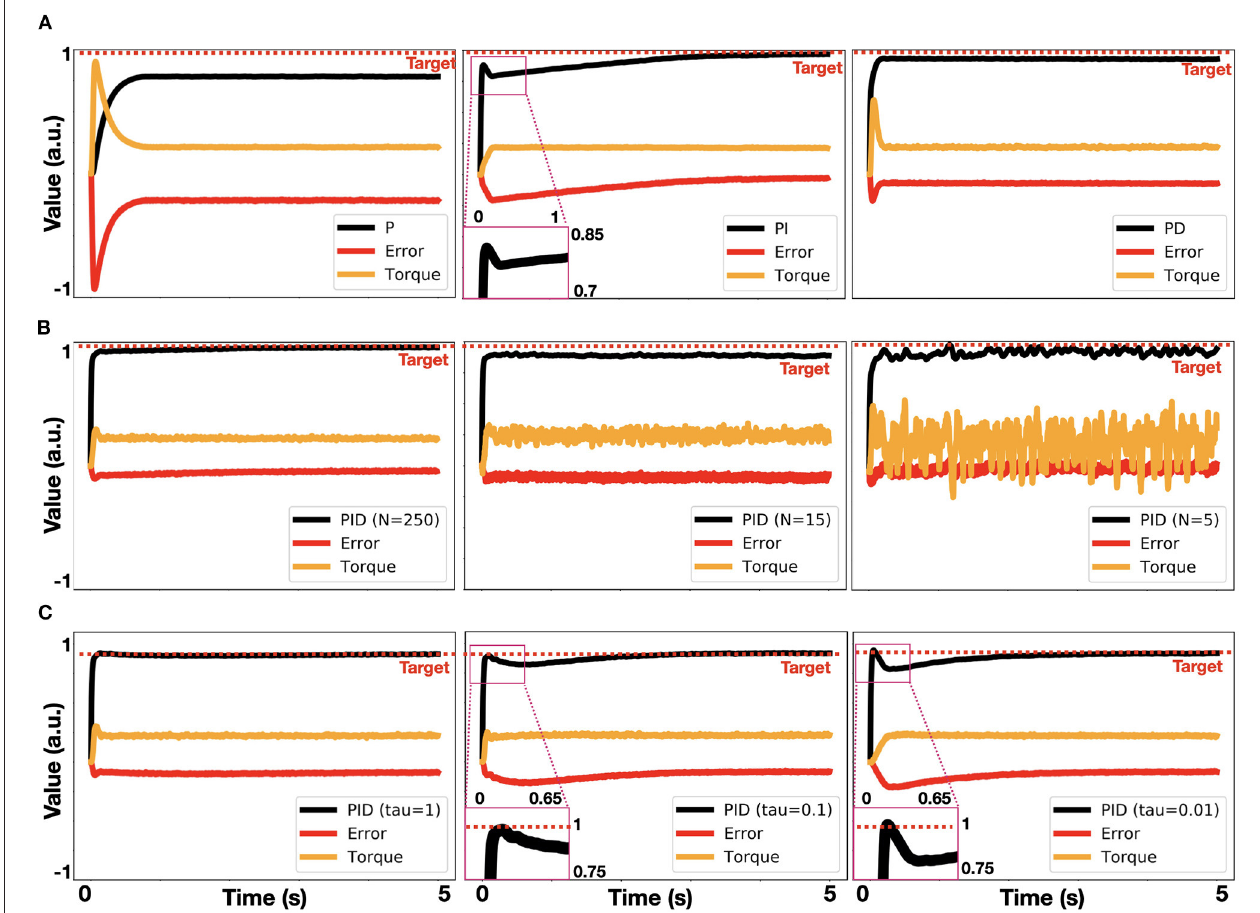
FIGURE 4 | Analysis of neuromorphic PID control. (A) Implemented P, PI and PD control (left to right), where τ i = 1, τ d = 1, k p = 2, k i = 1, k d = 0.4; (B) PID control implemented with 250, 15 and 5 neurons per ensemble per dimension (left to right); (C) PID control, implemented with τ i = 1, 0.1, 0.01 (left to